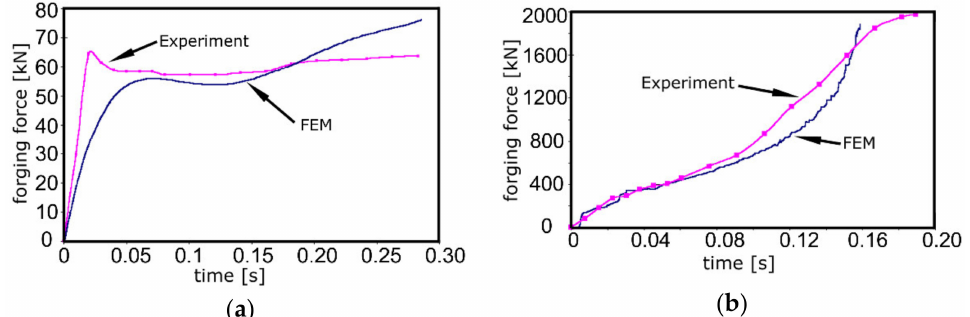
Figure 13. Development of forging forces in time during sequential processing: direct extrusion ( a ); stamping ( b